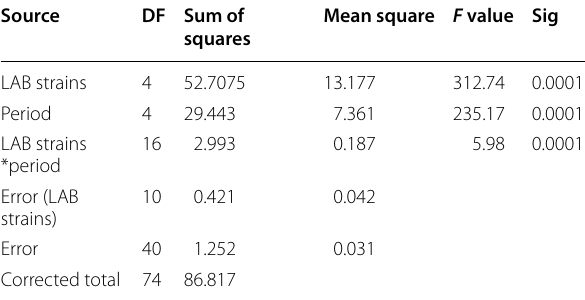
Table 3 ANOVA table of repeated measurement describes the effect of LAB strains, period and the interaction of LAB strains with period on means of encapsulation efficiency of LAB